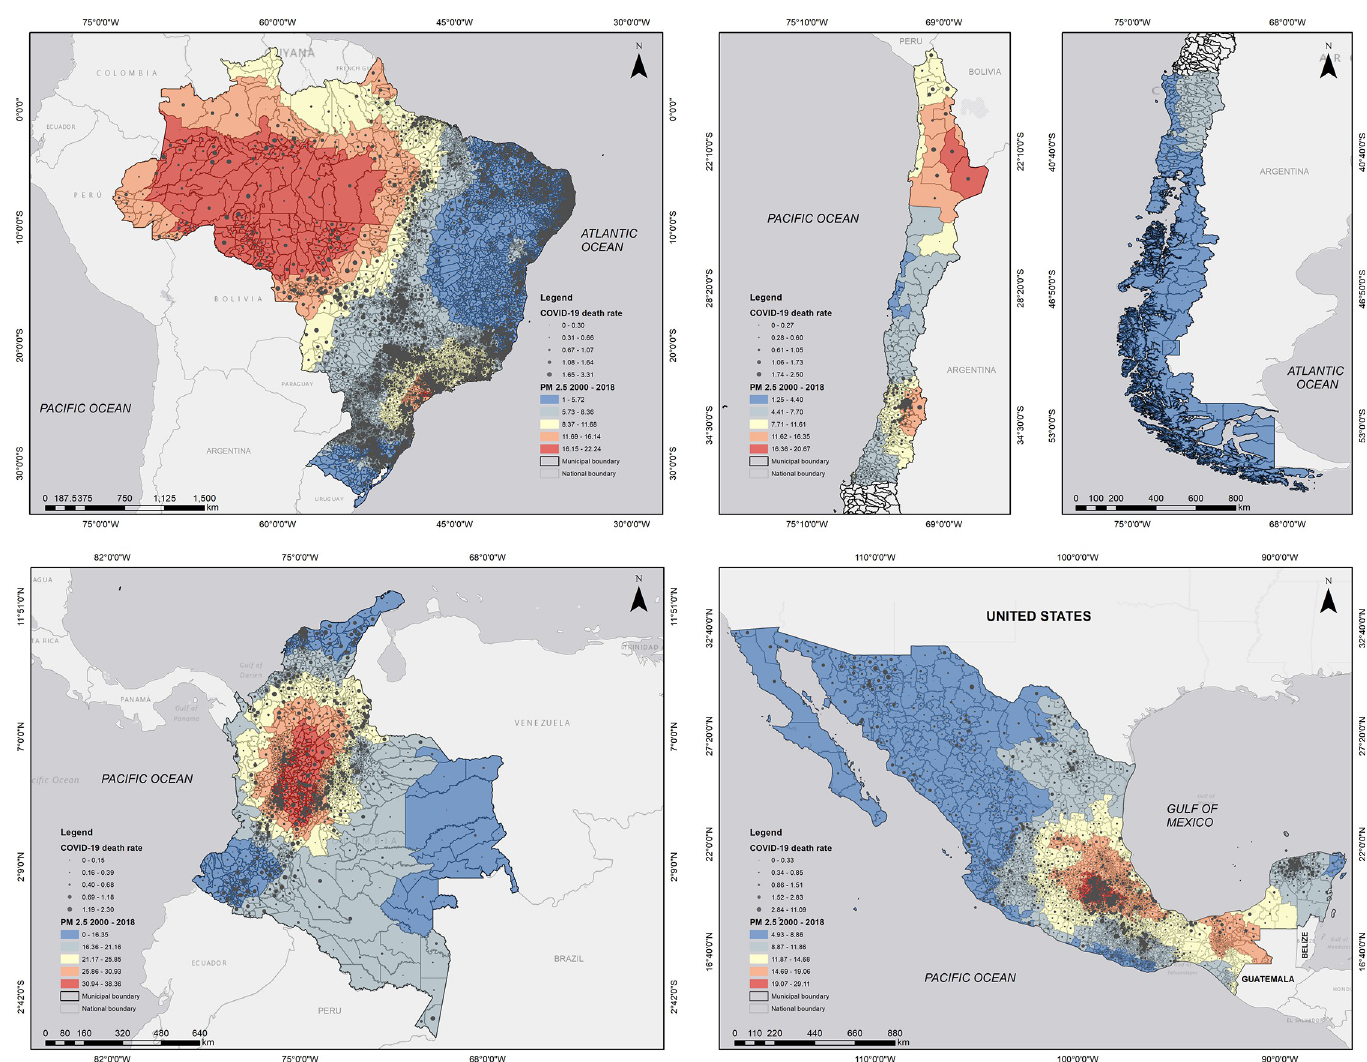
Fig 1. Distribution of long-term pollution (PM 2.5 ) concentrations and COVID-19 deaths in Latin America. a: Brazil; b: Chile; c: Colombia; d: Mexico. Notes: This figure shows the spatial distribution of long-term fine particulate matter (PM2.5) concentrations, averaged from 2000 to 2018, and 2020 COVID-19 mortality rate per 1,000 people across municipalities of selected countries in Latin America. We measure pollution in μ g/m3, and the data correspond to long-term trends of PM2.5 concentrations obtained from [45]. Data on municipality-level COVID-19 mortality rates come from each country’s official sources for 2020. Maps for this study were created in ArcMap 10.3. The basemaps were adapted from Esri, DeLorme, HERE [47] and have been republished under a CC BY license, with permission, original copyright (2021). The shapefiles for Brazil and Chile were adapted from [48, 49], respectively. The shapefiles for Colombia were adapted from IGAC [50] and have been republished under a CC BY license, with permission, original copyright (2022). The shapefiles for Mexico were adapted from INEGI [51] and have been republished under a CC BY license, with permission, original copyright